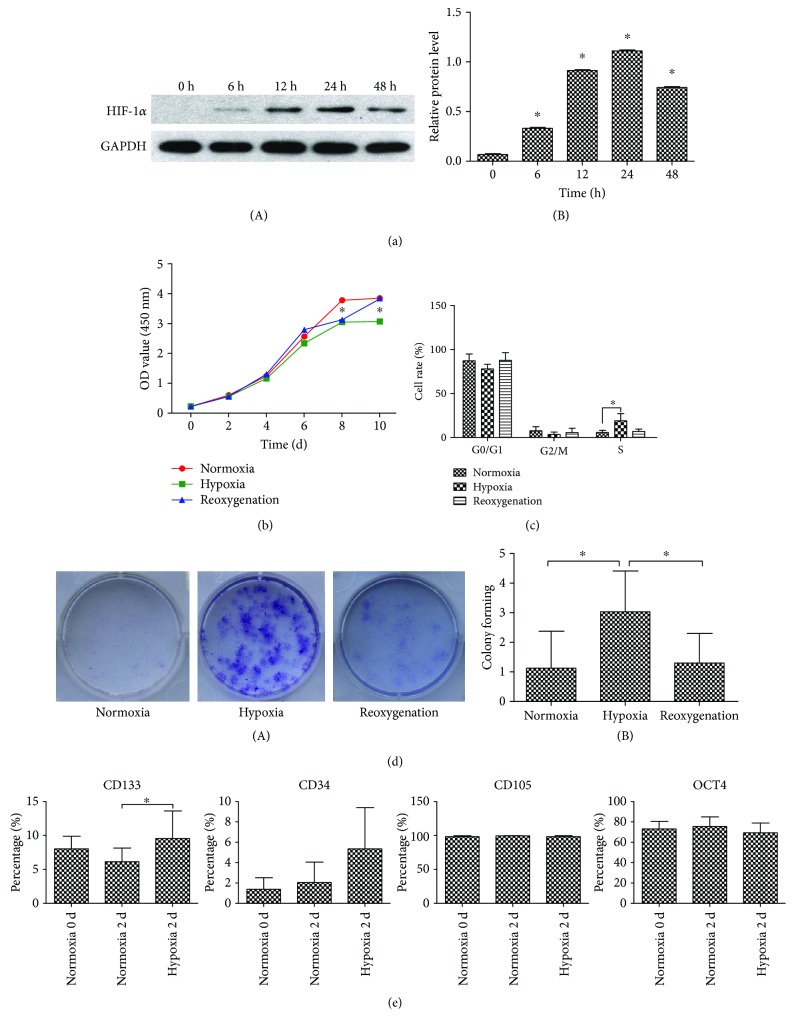
HP changed the cell phenotypes of hDPCs after culture under normoxia, hypoxia, and reoxygenation: (a) western blot assay and quantitative analysis of the expression of HIF-1α under normoxia and hypoxia at 0 h, 4 h, 8 h, 12 h, 24 h, and 48 h of culture; (b) proliferation ability of hDPCs in each group; (c) flow cytometry and quantitative analysis of cell cycle distribution in hDPCs after 3 d of culture under different oxygen concentrations; (d) colony-forming units and quantitative analysis in hDPCs after 10 d of culture; (e) expression of the mesenchymal stem cell surface markers CD133, CD34, CD105, and OCT4 in each group. Statistical significance is shown as ∗
p < 0.05.